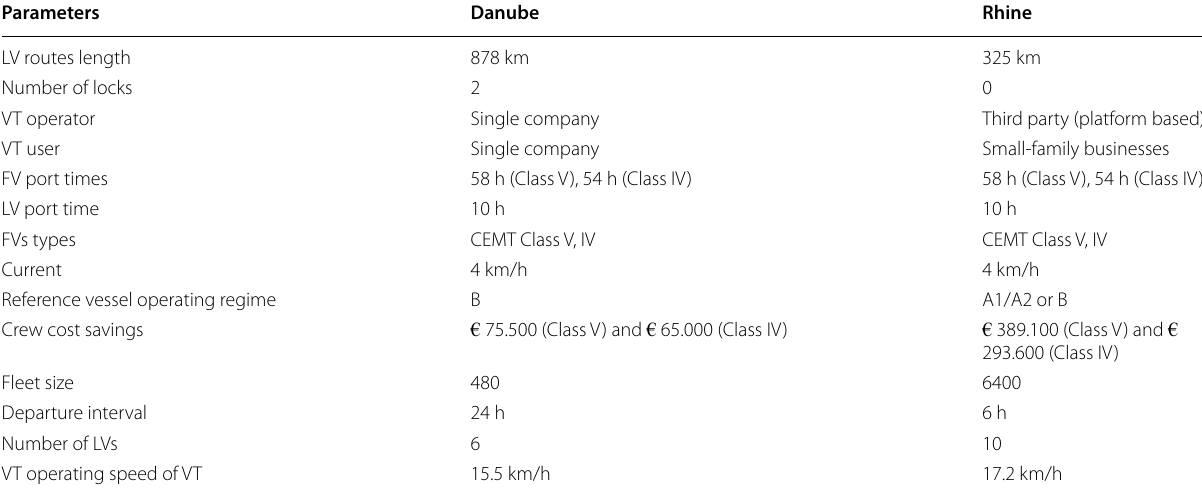
Table 3 Input data for corridor cases